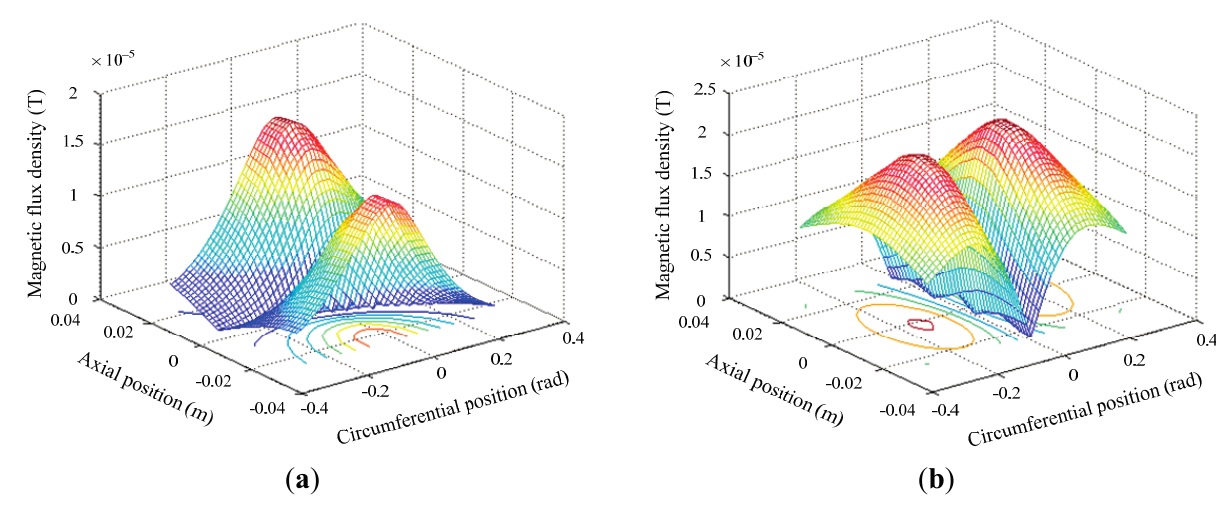
Figure 6. Perturbation field caused by ( a ) Circumferential crack; ( b ) Axial